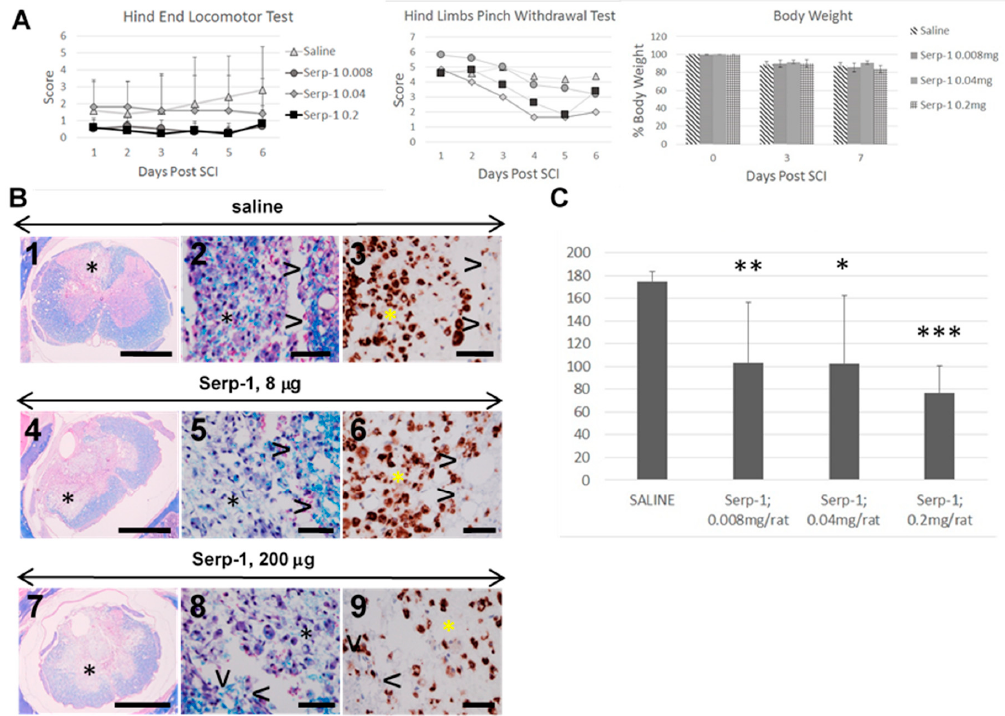
Figure 1. Effect of rising dose of Serp-1 on macrophage infiltration at 7 days post-injury. ( A ) Clinical